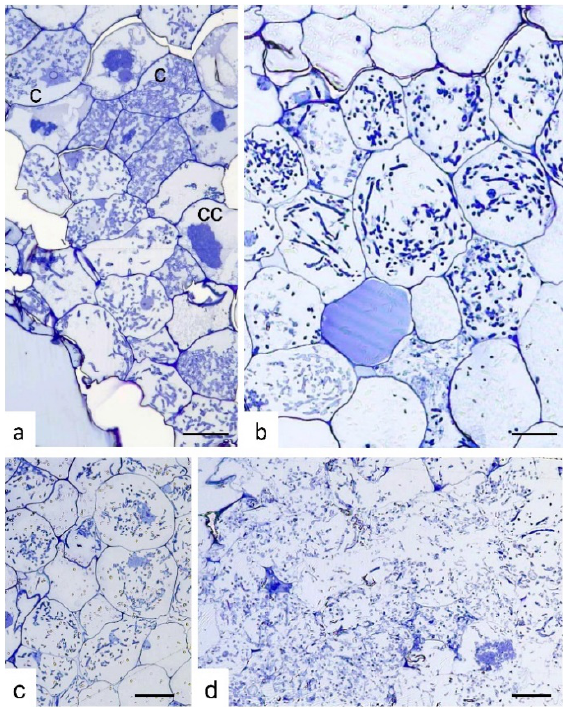
Figure 2. Semi-thin sections of Serapias vomeracea protocorms colonized by Tulasnella calospora . ( a ) Stage where protocorms appeared with the typical features and color. At cellular level, typical colonization pattern with T. calospora is evident with the presence of coils at different developmental stages. c, coil; cc, collapsed coil. ( b , c ) Subsequent stages where protocorms are becoming brown. The fungal colonization pattern is still evident as well as host cell features. ( d ) Section of a dark/soft protocorm. Cell borders are not well-defined and the fungal hyphae are widespread in the tissues without a typical colonization pattern. Bars = 33, 13, 45, 25 μm for (a), (b), (c) and (d), respectively.